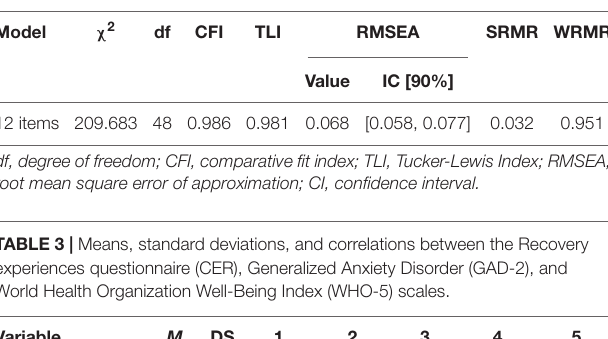
TABLE 2 | Fit indices of the model evaluated by confirmatory factor analysis (CFA) of the study instrument.